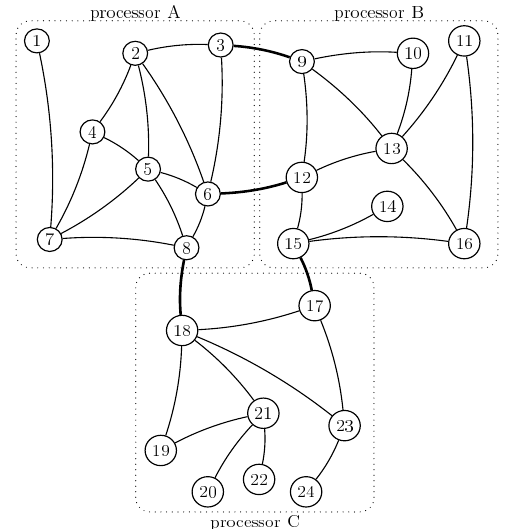
Figure 2. Min-cut partitioning of a sample graph G(24,36) among three processors; each processor node has 8 vertices; 4 intra-cluster edges (highlighted in bold) and 32 inter- cluster